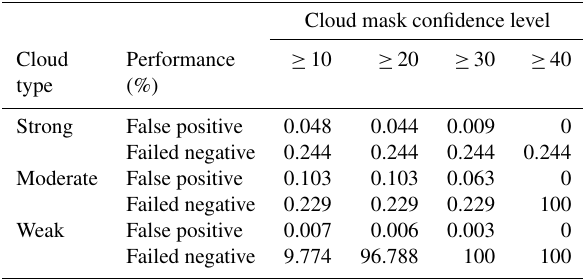
Table 1. Summary of false positives and failed negatives for hy- pothetical strong, moderate and weak cloud cases in Fig. 5a1, a2 and a3,